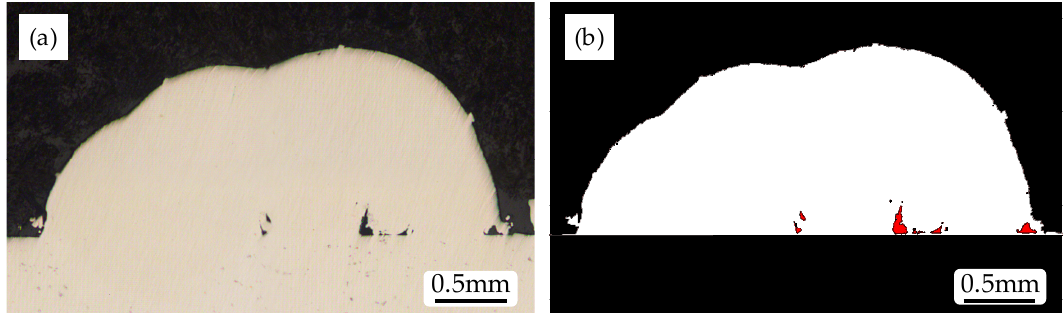
Figure 2. ( a ) Original; ( b ) Post-processed images of a cross section.